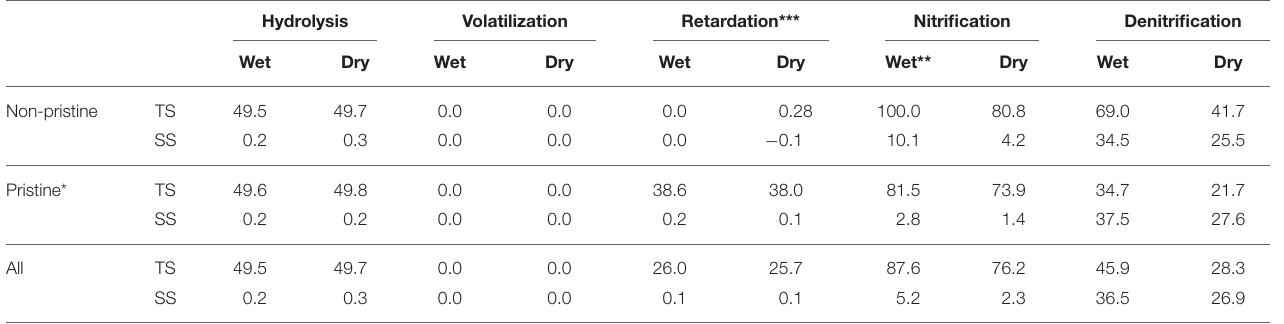
TABLE 2 | Percentage of annual nitrogen surplus (N surpl ) being transformed by hydrolysis, volatilization, nitrification, denitrification and retarded by ad- and desorption processes. Hydrolysis Volatilization Wet Wet Dry Wet Dry Wet** Wet